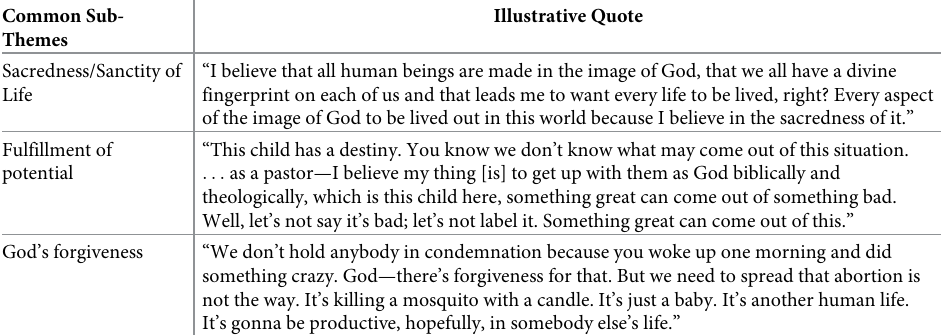
Table 3. Illustrative quotes of religious and moral belief